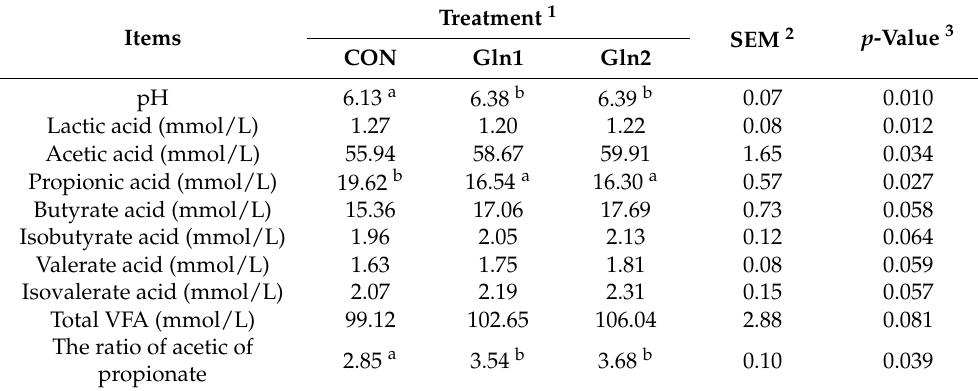
Table 4. Effects of adding Gln to high concentrate on rumen fermentation parameters of lambs.